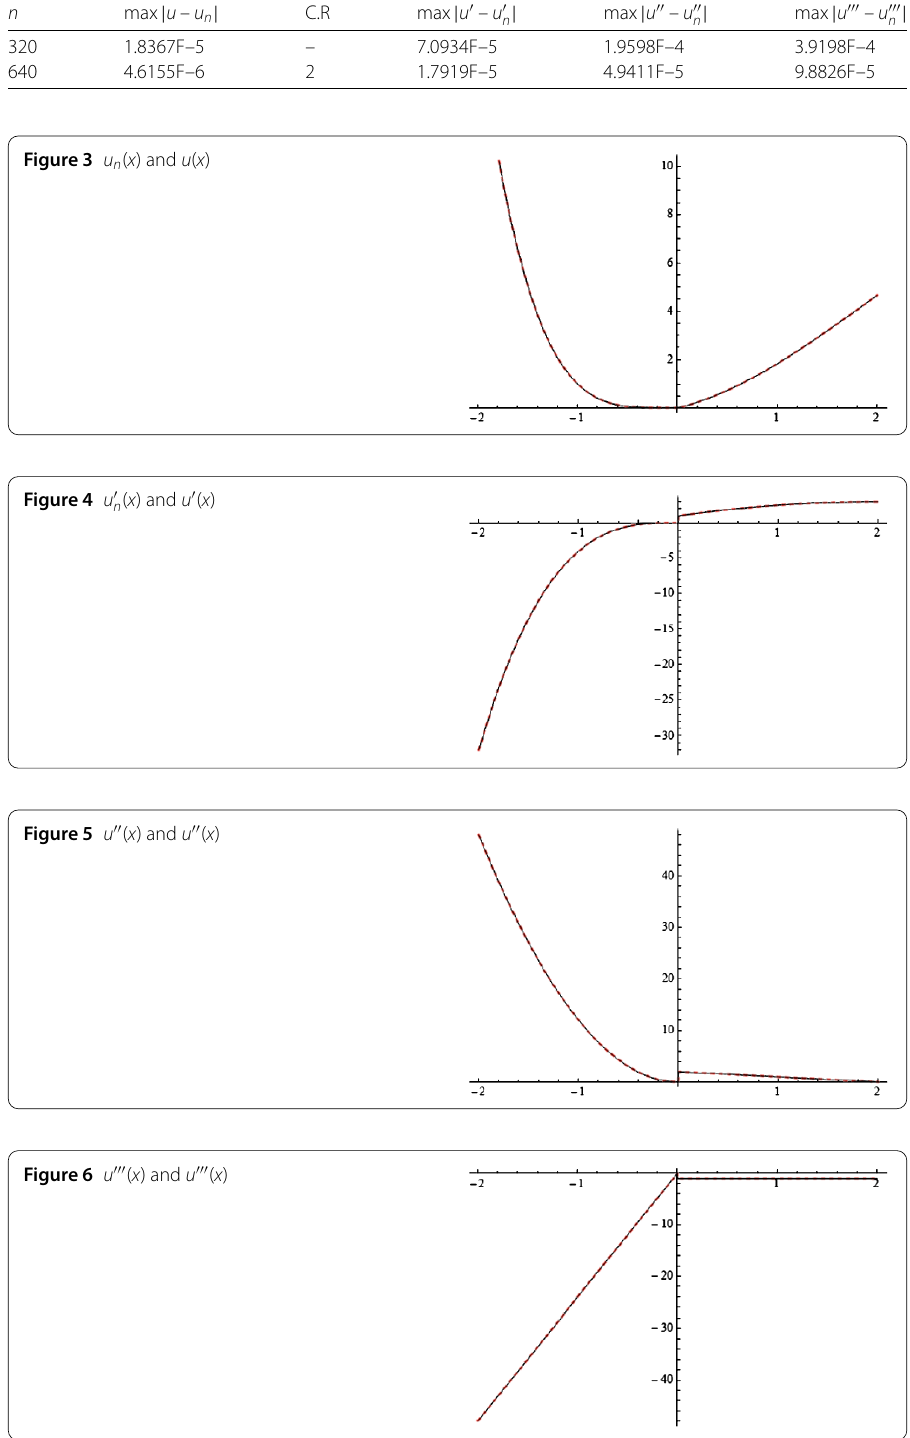
Figure 6 u (cid:2)(cid:2)(cid:2) ( x ) and u (cid:2)(cid:2)(cid:2) ( x